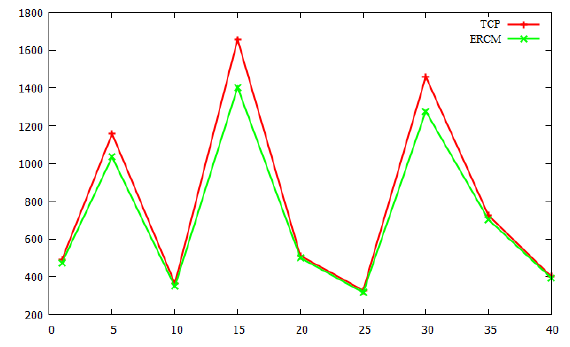
Fig. 8. Congestion loss vs. Mobility for 75 flows